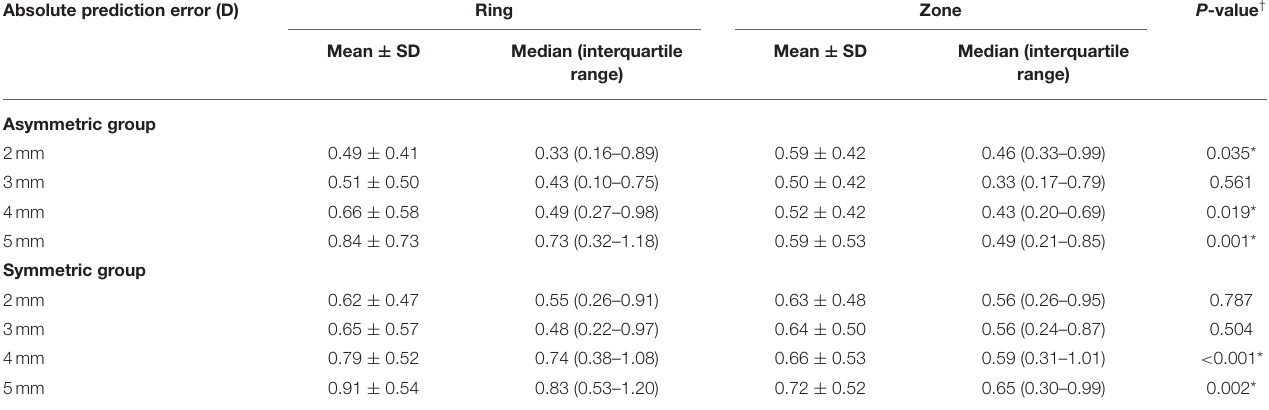
TABLE 3 | Prediction errors of corneal astigmatism based on the ring or zone mode centered on the corneal apex in the asymmetric and symmetric groups. Absolute prediction error